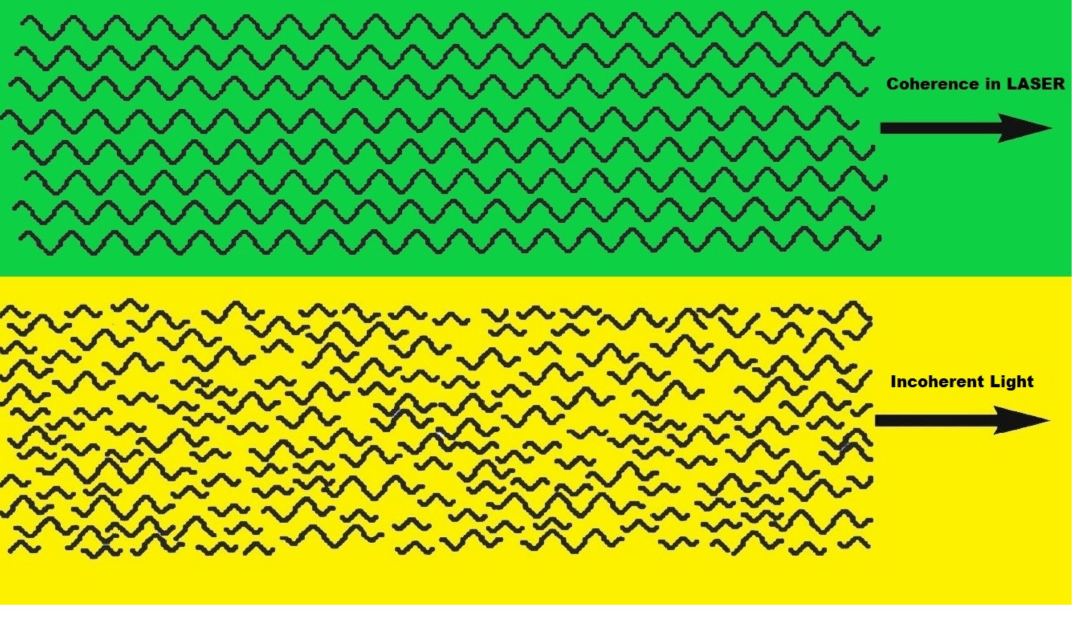
Figure 3. Coherent and incoherent